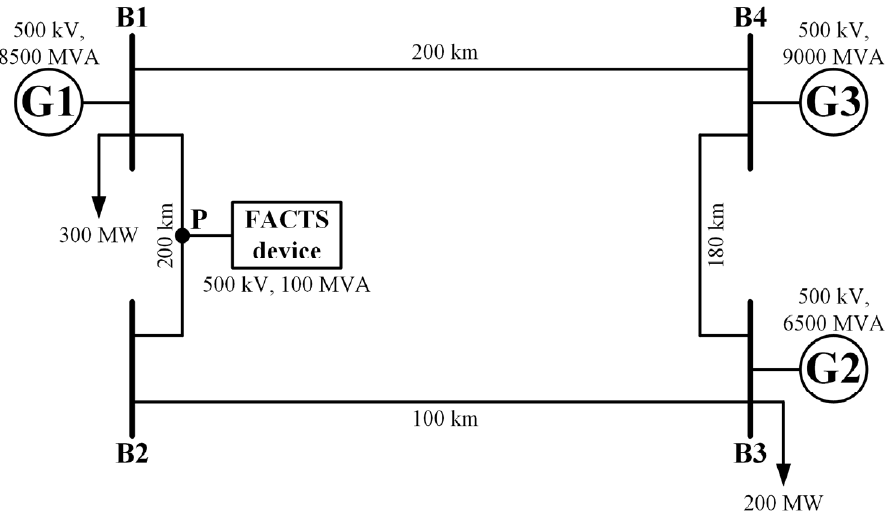
Figure 1. Single line diagram of the studied